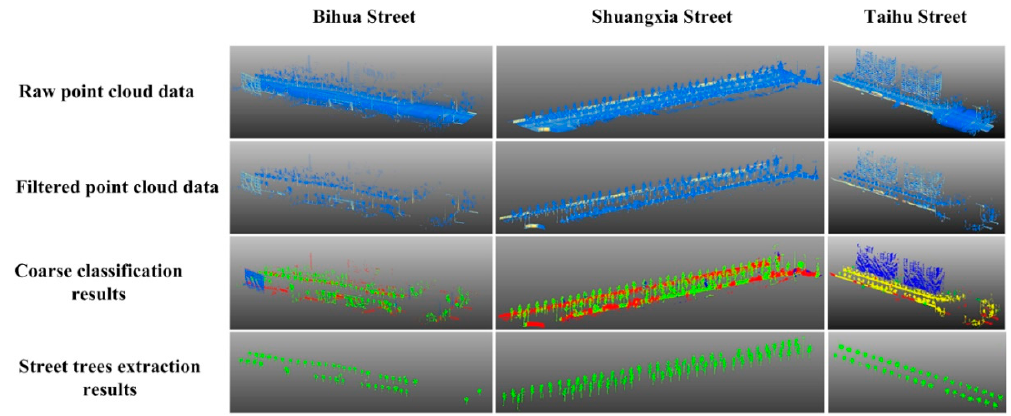
Figure 12. Extracting street trees from raw point cloud data.